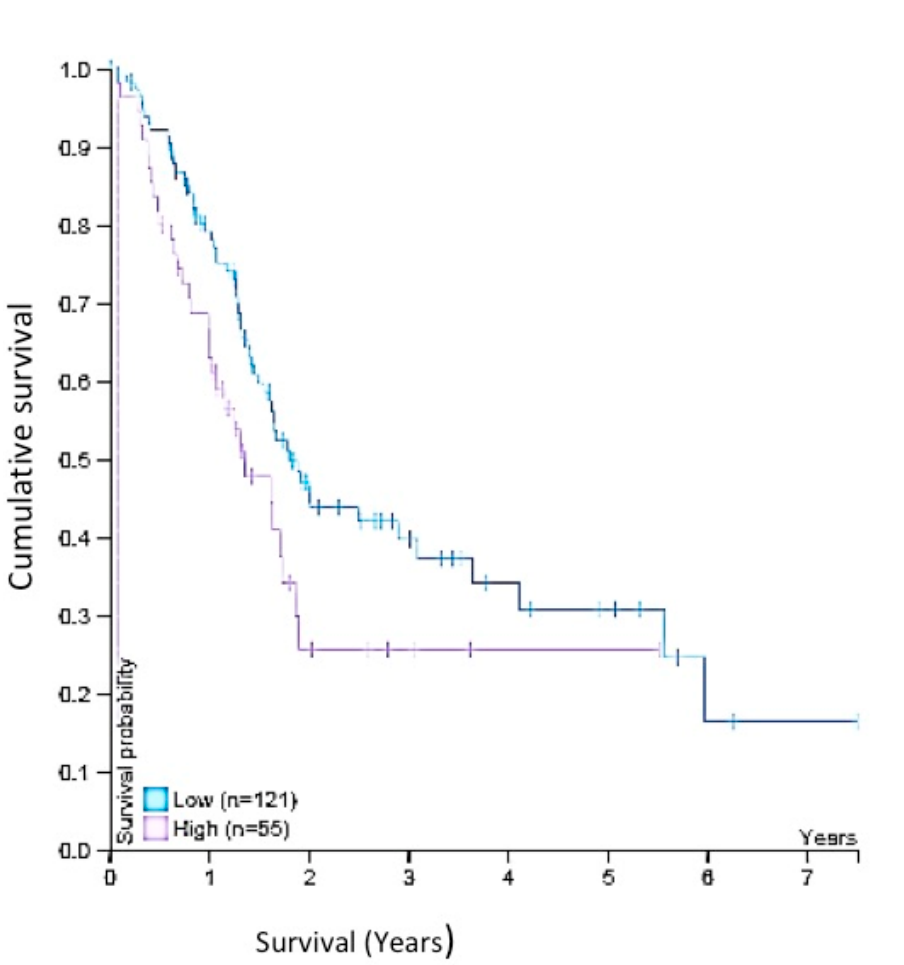
Figure 5. A survival curve gained from Human Protein Atlas shows that a high expression of Wnt-11 reduces cumulative survival of PDAC. ( p = 0.02). A low expression ( n = 121) . High expression ( n = 55). 5-year survival high 26%; 5-year survival low 31%. [34]. Kaplan–Meier survival estimators examined the prognosis of each group of patients, and the survival outcomes of the two groups were compared. Bylog ranktests. https://www.proteinatlas.org/ENSG00000085741WNT11/pathology/pancreatic +